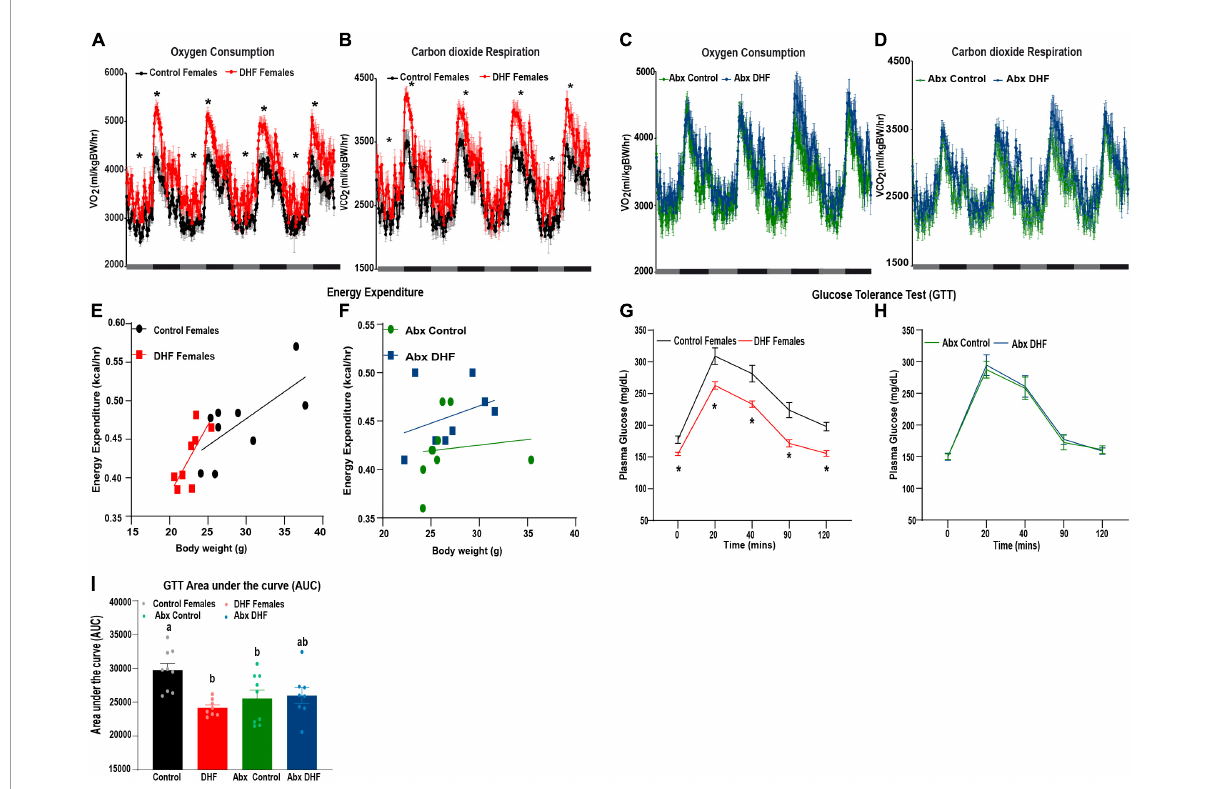
FIGURE3 Effect of DHF on energy expenditure and glucose tolerance in conventional and gut microbiome ablated females. (A,C) O 2 consumption, (B,D) CO 2 respiration, and (E,F) average cumulative energy expenditure were measured via indirect calorimetry over a 4-day period after 8 weeks of HFD-feeding. (G–I) Glucose tolerance was measured and area under the curve (AUC) was calculated after 10 weeks of HFD-feeding. Data are expressed as average ± SEM ( n = 8–9). * p < 0.05 vs. sex-matched controls. Statistical analysis for indirect calorimetry data (A–F) was performed by analysis of covariance using web-based analysis tool CalR. Data in panels (G–I) were analyzed by one-way ANOVA followed by Bonferroni post hoc comparison. Significant differences are identified by * or different